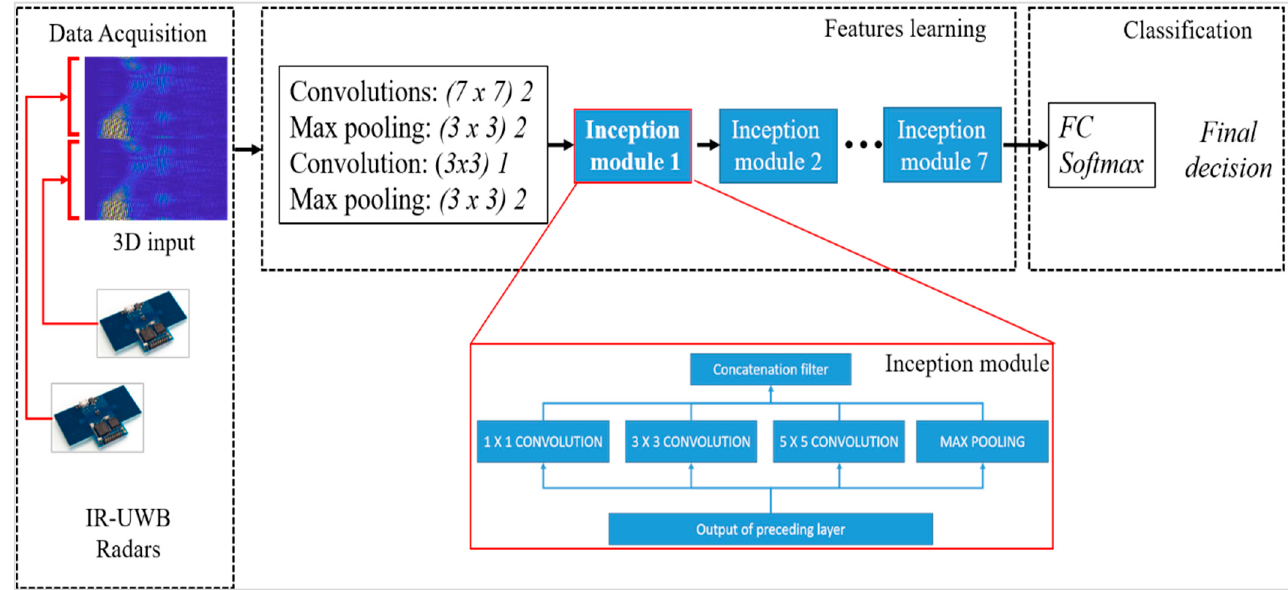
Figure 8. A deep-learning framework for UWB Impulse Radar. Data from two radars are concatenated together and fed as input to inception-module based modified GoogLeNet Net architecture Ahmed et al. [12].